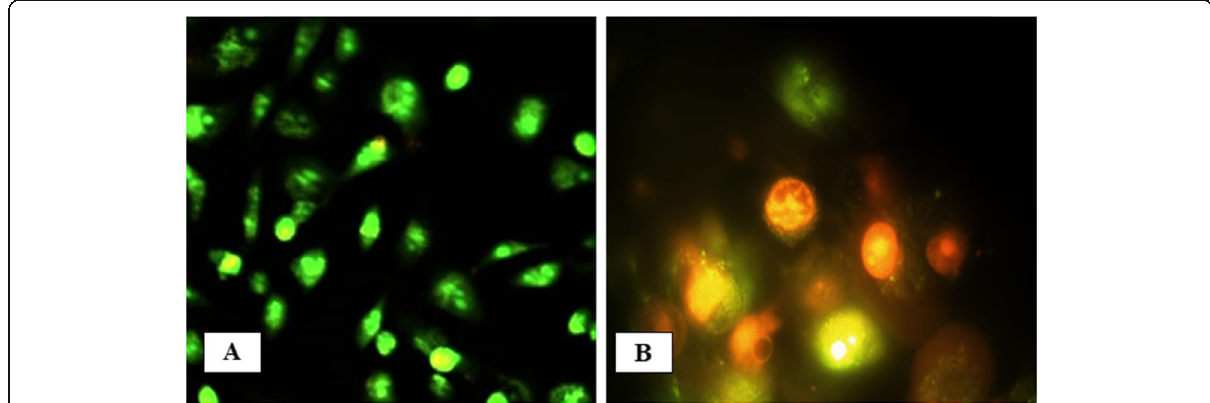
Fig. 5 Aciridine orange staining of MCF-7 cell monolayers at control and NP-treated conditions. a Untreated cells. b Cells were treated with 100 μ g/ml of Ag